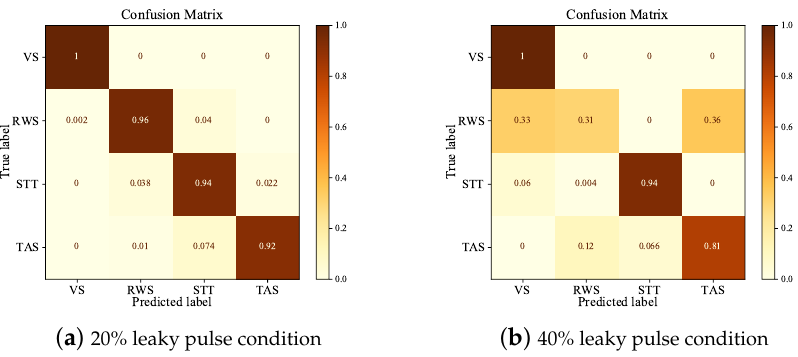
Figure 13. Mode recognition confusion matrix using MSJR.